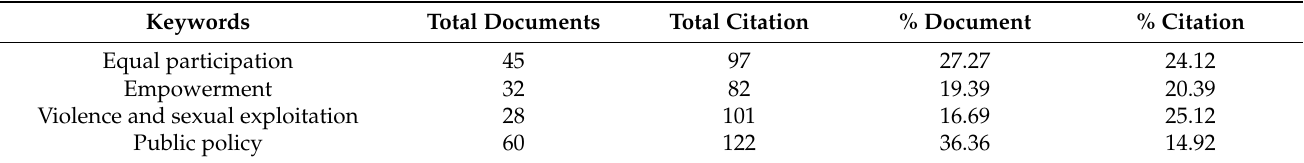
Table 2. Focus on gender equality.